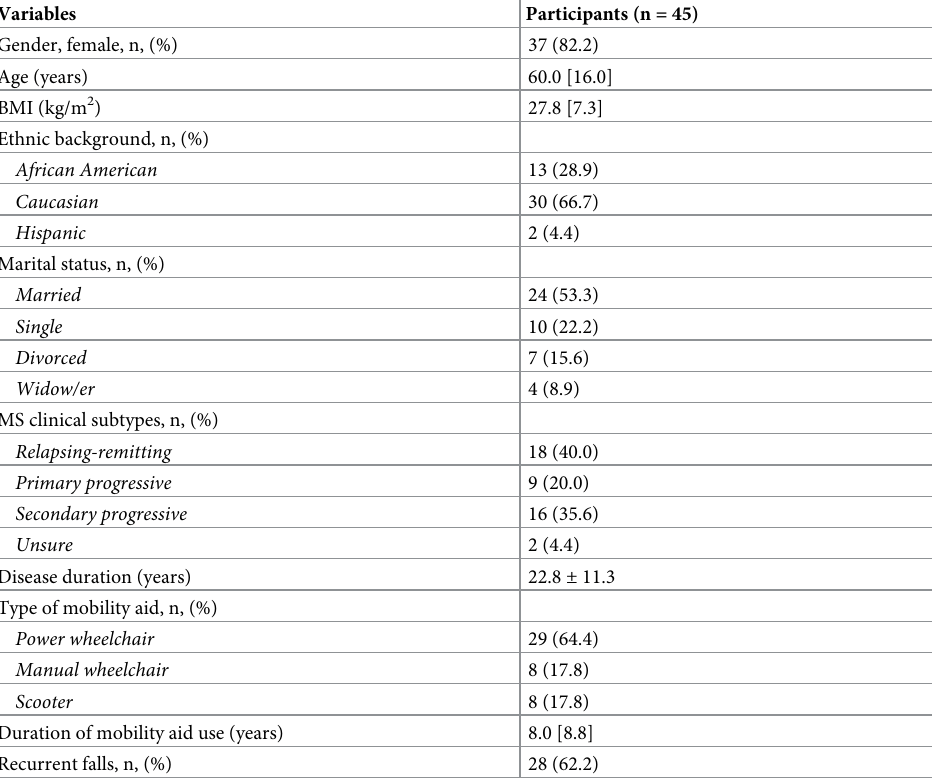
Table 2. Sociodemographic and clinical characteristics: Results are expressed as percentages for categorical vari- ables and mean ± SD or median [IQR] for continuous